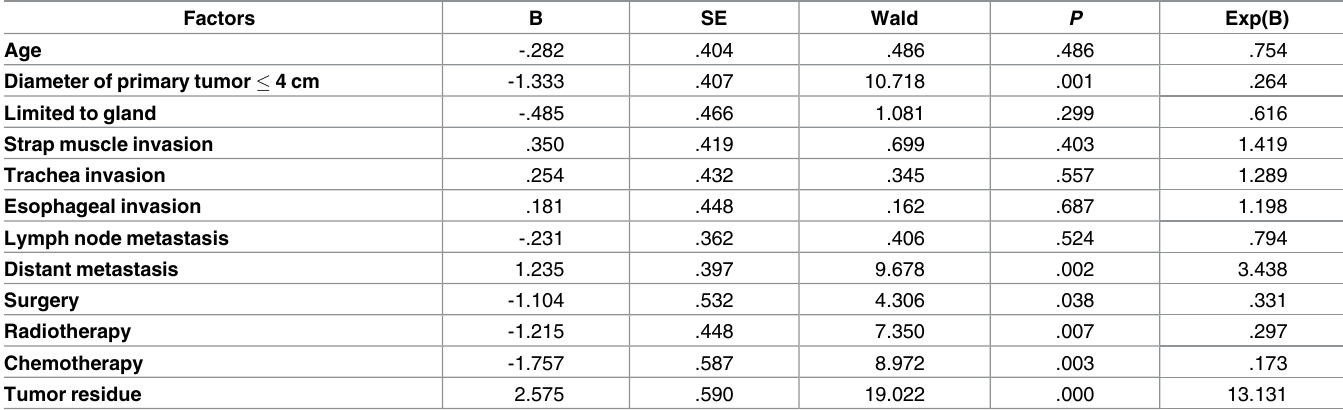
Table 4. Multivariate analysis results of factors affecting the